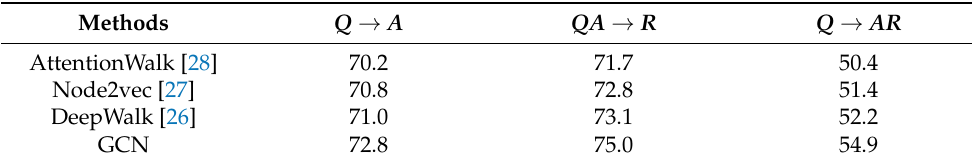
Table 1. Comparison between knowledge graph embedding